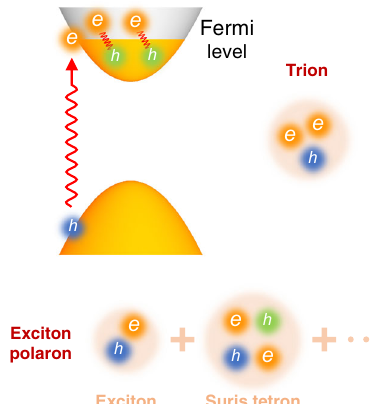
Fig. 1 Schematic of trion and exciton polaron. When a photo-generated exciton interacts with the Fermi sea (FS), it can excite many electron – hole pairs on the FS. The trion is a bound state between an exciton and one FS electron. The exciton-polaron state is the linear combination of a bare exciton, an exciton dressed with one FS electron – hole pair (Suris tetron), and higher-order components that represent an exciton dressed with two and more FS electron – hole